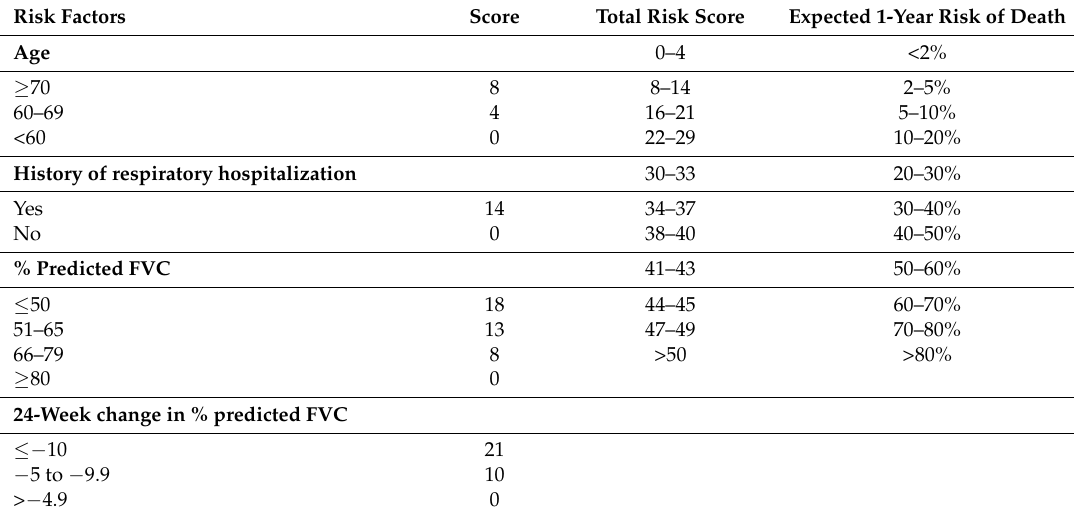
Table 3. Du Bois Prognostic